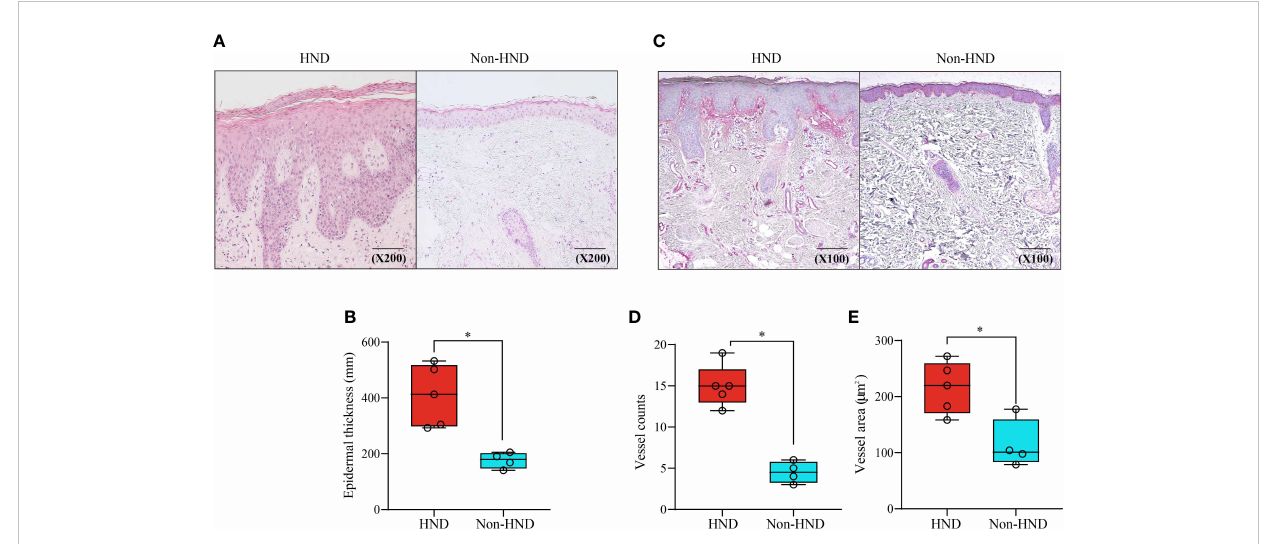
FIGURE 2 Histopathological comparison of facial skin of HND and non-HND subjects. (A) Representative image biopsy specimen of HND (left) and non- HND (right) facial pathology. (B) Average epidermal thickness of patients with HND was higher than that of non-HND subjects. (200x magni fi cation) (C) Immunohistochemistry of the upper dermis for factor VIIIa-related antigen of patients with (left) and without (right) HND. (200x magni fi cation) (D) Average vessel count and average vessel area of patients with HND was signi fi cantly higher than that of non-HND subjects. (Mann-Whitney U Test, (B) p = 0.0159, (D) p = 0.0159 (E) p = 0.0317) HND, Head and neck dermatitis. * : p<0.05.